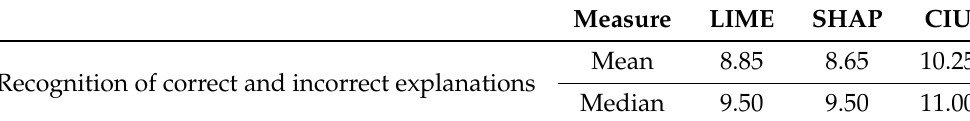
Table 9. Mean and median values of users’ ability to recognize correct and incorrect explanations.